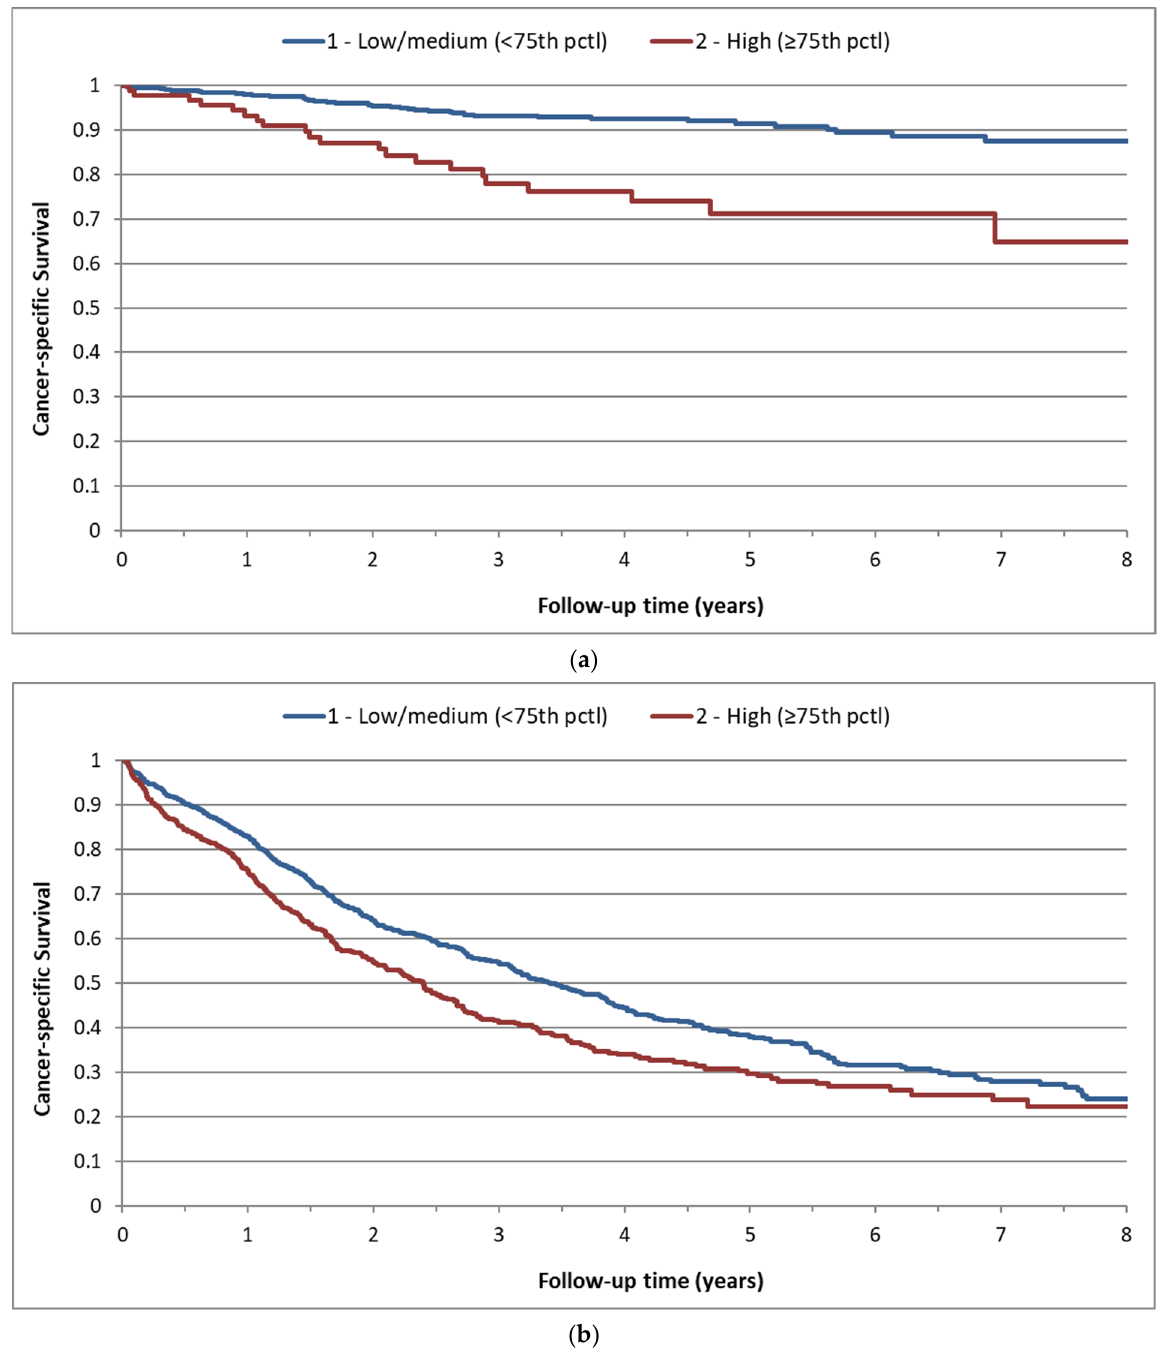
Figure 2. Cancer-specific survival by baseline platelet count category, for ovarian cancer patients. ( a ) Ovary (stage I/II patients) ( n = 651); ( b ) ovary (stage III/IV patients) ( n = 1425).